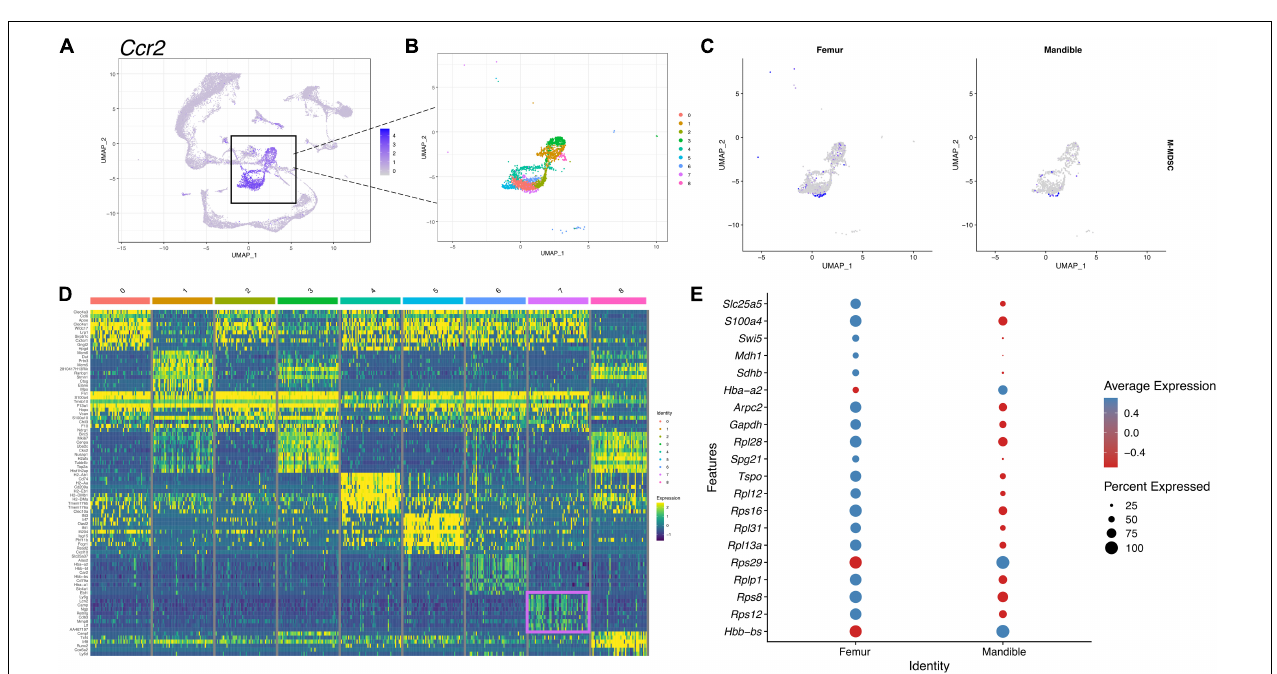
this population was significantly reduced in the mandible compared to femur, indicating that the overall myeloid cell was deficient in